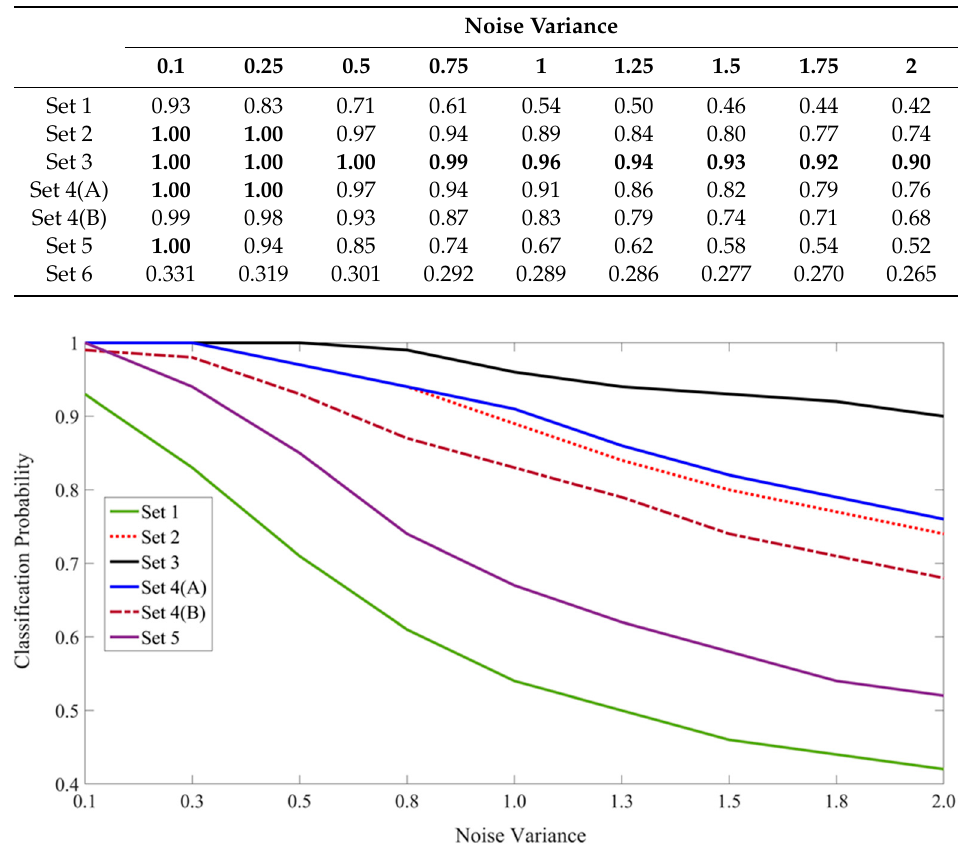
Figure 15. The plot of the classification probabilities for the six sets of experiments involving the classification of non-ambiguous target letters.